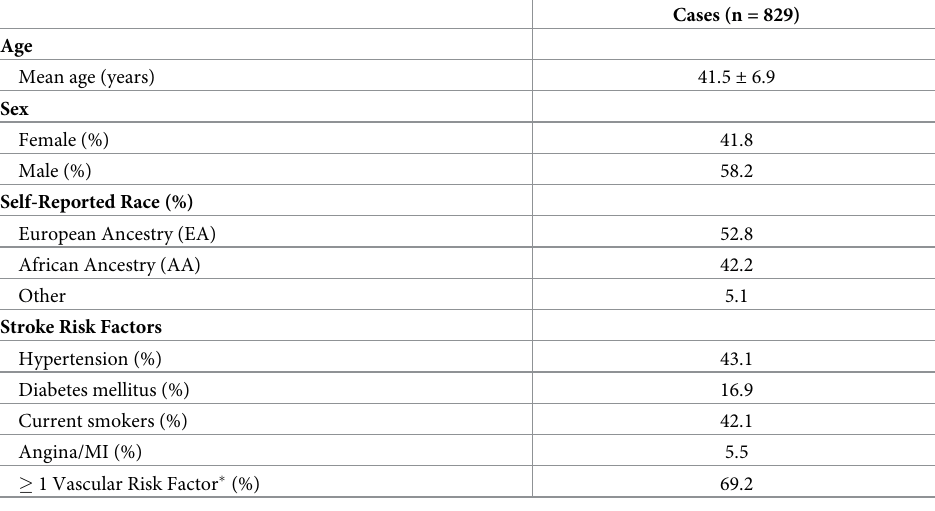
Table 1. Age, sex, race and risk factor